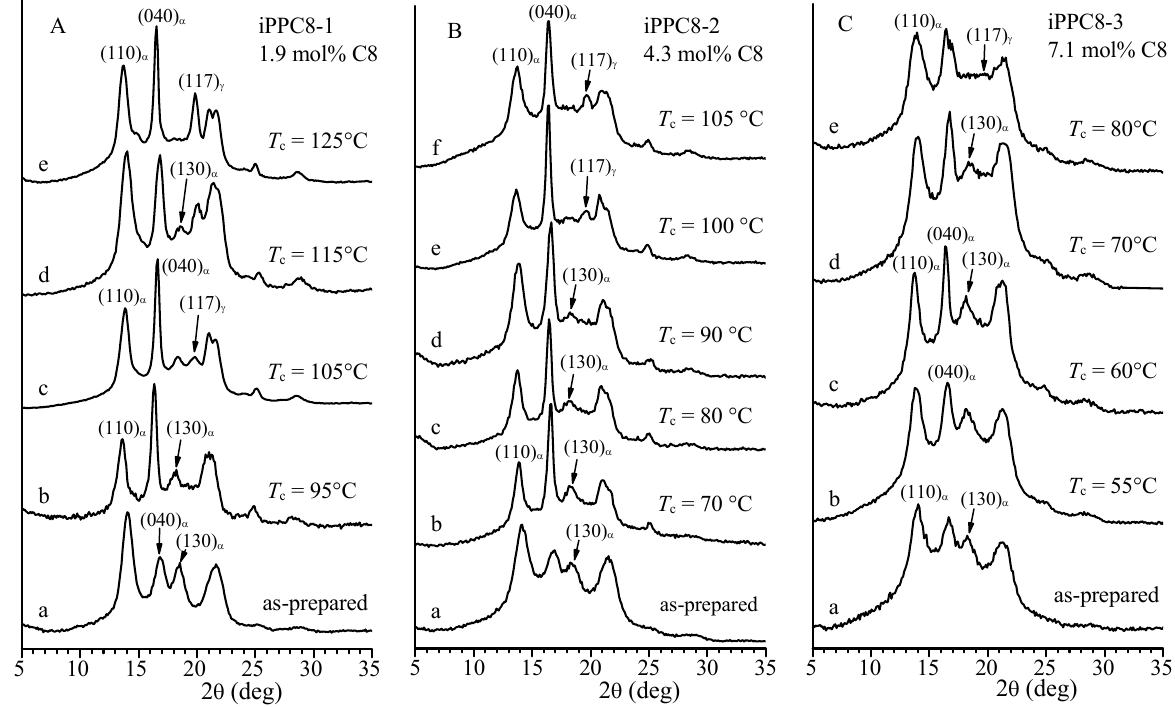
Figure 3. X-ray powder diffraction profiles of samples isothermally crystallized from the melt at the indicated crystallization temperatures T c ( b – f ) of the samples iPPC8-1 with 1.9 mol% of octene ( A ), iPPC8-2 with 4.3 mol% of octene ( B ), and iPPC8-3 with 7.1 mol% of octene ( C ). The diffraction profiles of the as-prepared samples are also reported (profiles ( a )). The (110) α , (040) α , and (130) α reflections at 2 θ = 14 ◦ , 17 ◦ , and 18.6 ◦ , respectively, of the α form of iPP and the (117) γ reflection of the γ form at 2 θ = 20.1 ◦ , are